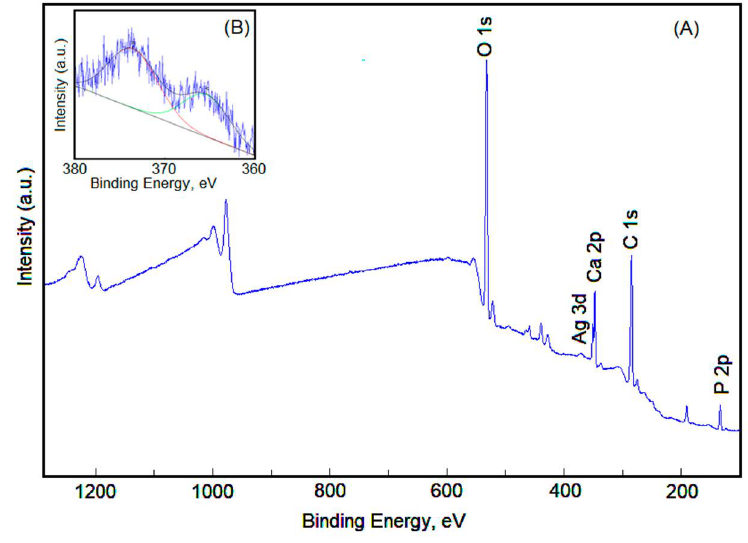
Figure 2. XPS general spectrum of 0.05 AgHAp thin film ( A ). The high resolution XPS spectra of Ag (3d) XPS peak of 0.05 AgHAp thin film ( B ).